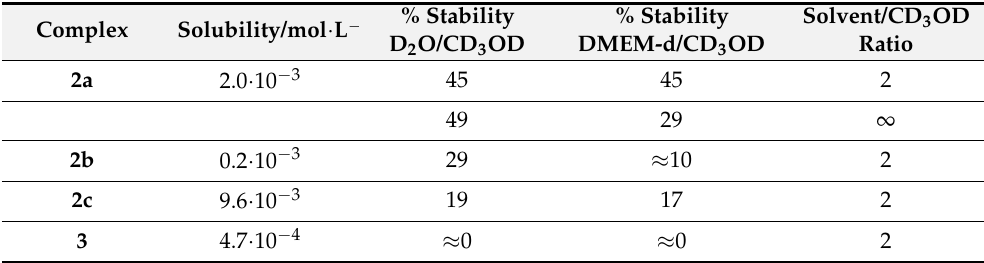
Table 1. Solubility of diiron amine complexes in D 2 O (based on 1 H NMR spectroscopy, DMSO 2 as internal standard). Residual % of complex in aqueous media after 72 h at 37 ◦ C, and solvent (D 2 O or DMEM-d) over CD 3 OD